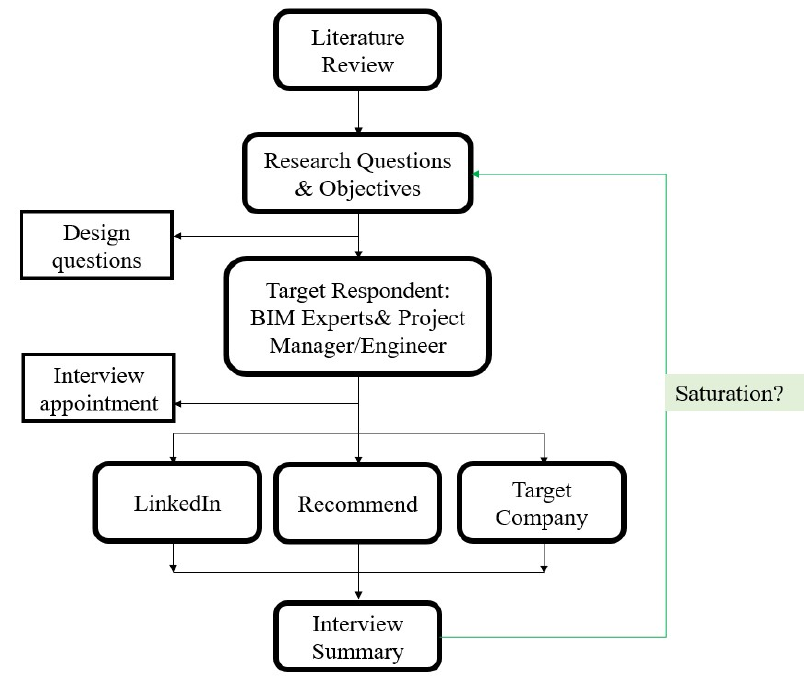
Figure 1. Data collection process flow.